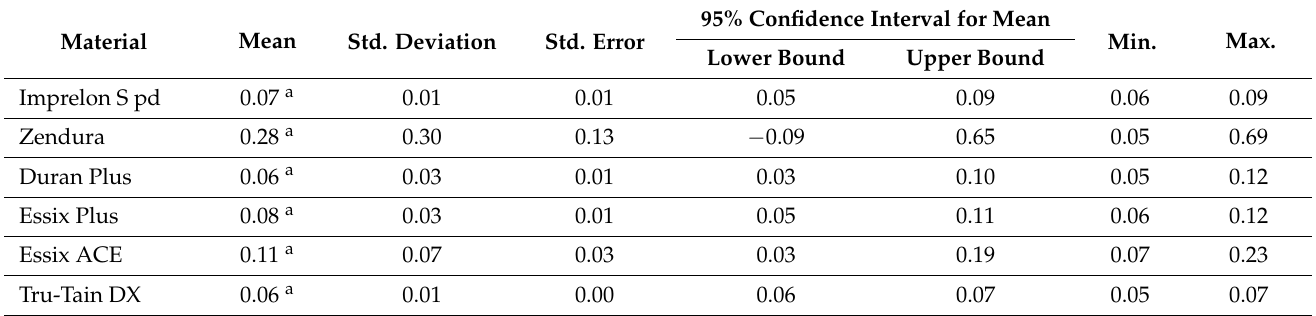
Table 4. Descriptive analysis of roughness values of Group 1 (the same small letter indicates no significant difference between materials at p < 0.05